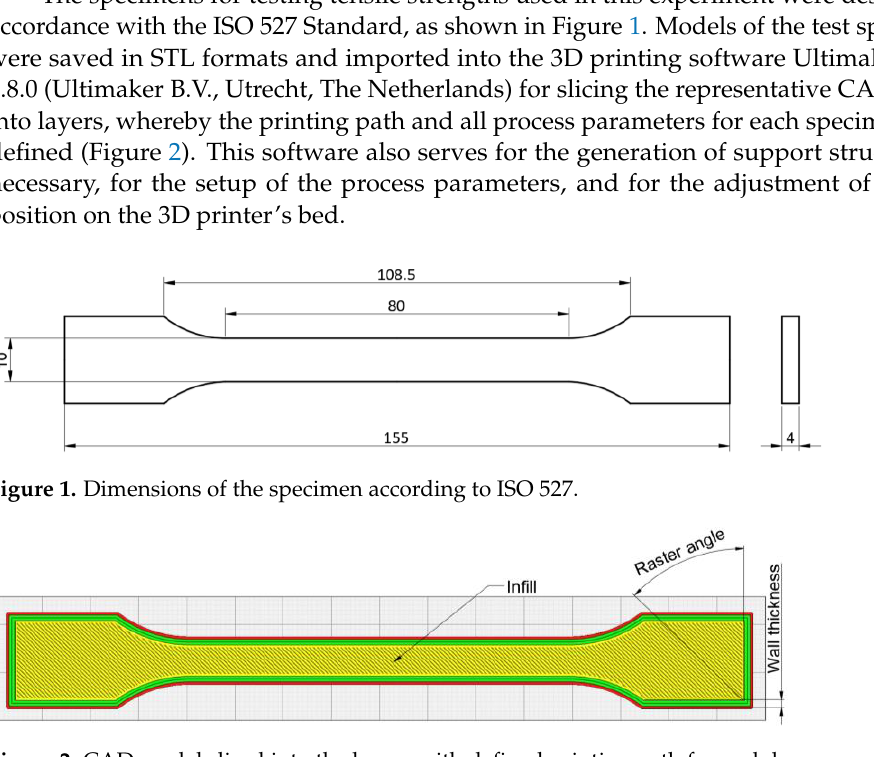
Figure 2. CAD model sliced into the layers with defined printing path for each layer.